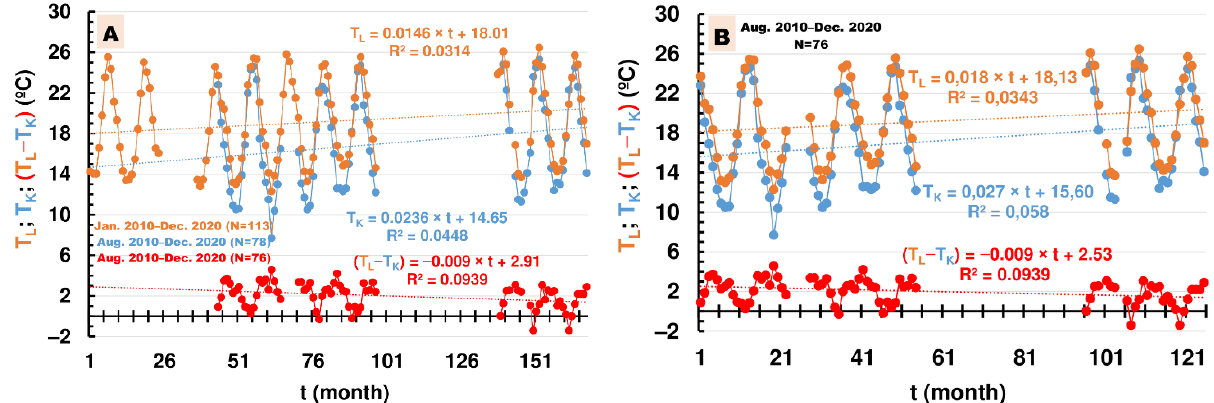
Figure 8. Time series of the mean monthly sea surface temperatures at Lastovo (brown) and Krk (blue) and their differences (red) for all available data ( A ), and only for those when measurements were taken at both stations ( B ).